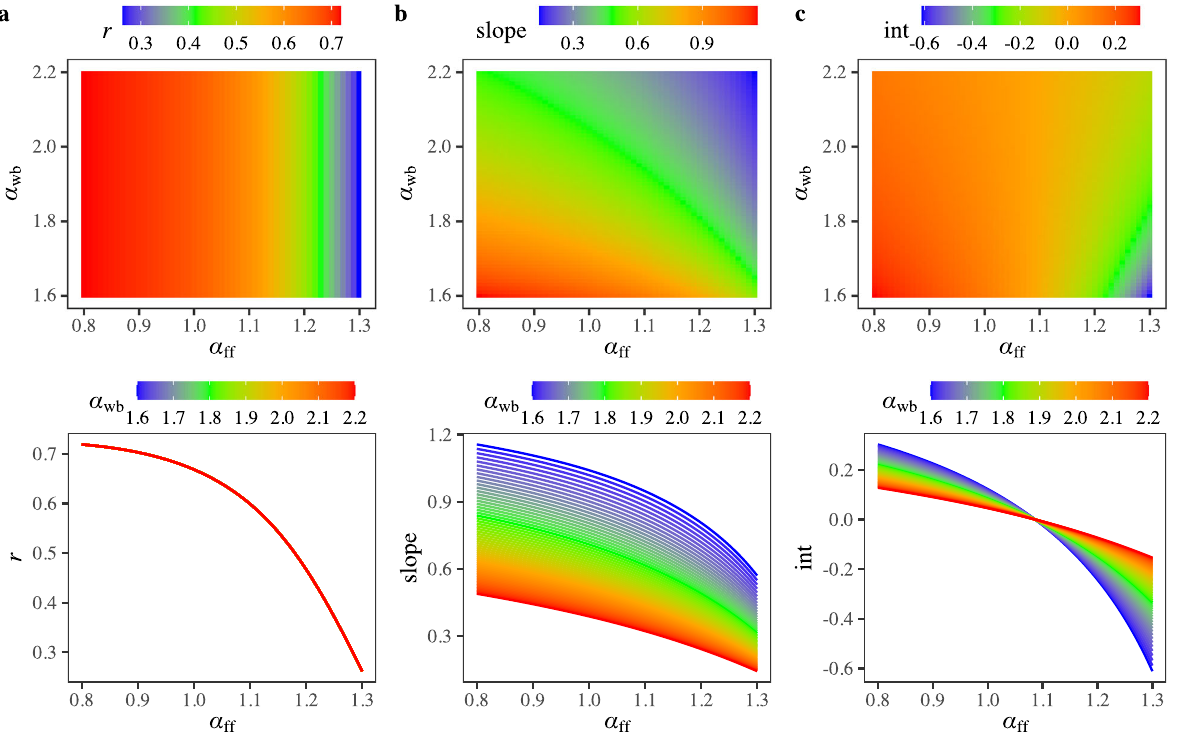
Fig. 2 Diagnostic parameters of linear regression equation as the function of different α combinations. a Pearson correlation coef fi cient ( r ). b Slope. c Intercept (int).